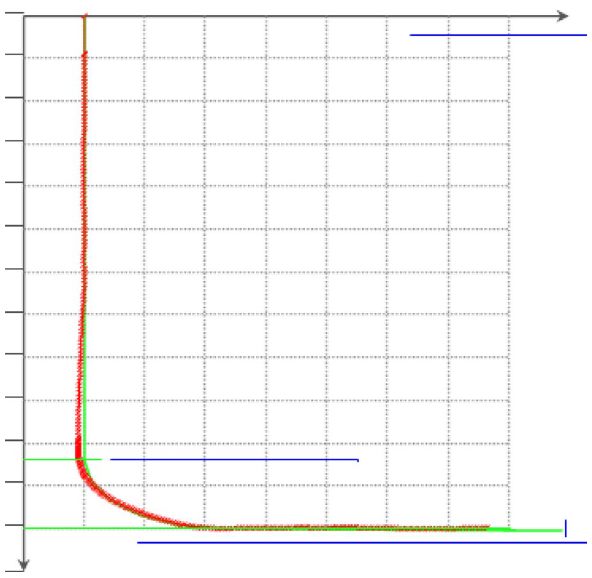
Fig. 18 Borehole trajectory map